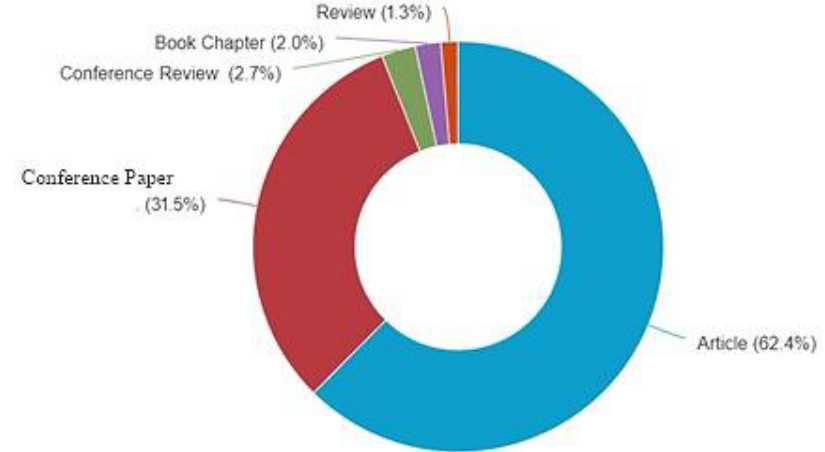
Figure 4. Document types of the publications according to Scopus search results.